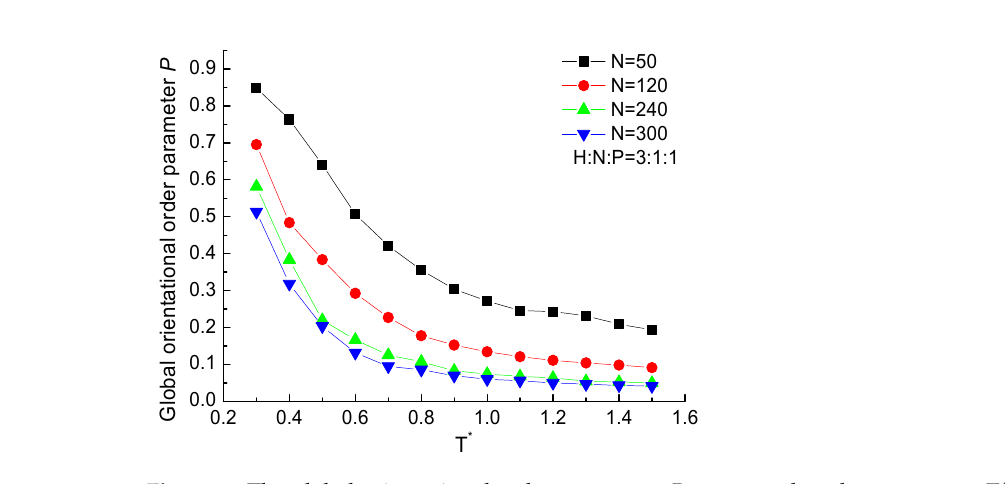
Figure 5. All curves show that the radius of gyration of the protein chain increases with the decrease of temperature. This tendency is independent of chain length and repeating unit. But comparing the proteins constructed by different repeating units, for the chain with higher proportion of H residues in a repeating unit may lead to the lower value of the radius of gyration presenting the compact structure comparatively. On the other hand, the structural size of the protein constructed by the low percentage of hydrophobic residues changes more obviously than the one formed by high percentage of H beads. It means the configuration of the protein with low ratio of hydrophobic residues is flexible and easily influenced by temperature. The protein constituted by more hydrophobic residues could form a relatively stable structure that is hardly influenced by temperature. It also demonstrates that more H-H pairs interactions could maintain the stability of the protein structure.